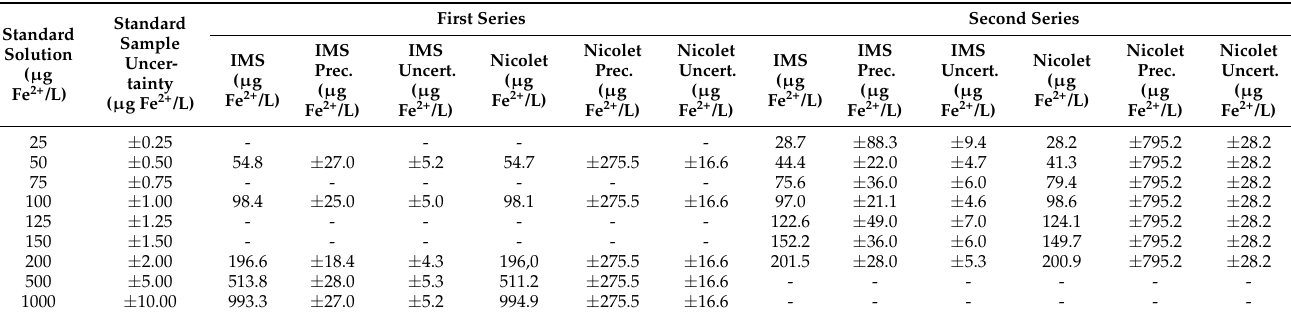
Table 2. Uncertainty analysis of standard solutions for IMS and Nicolet Evolution 300 in first and second series of